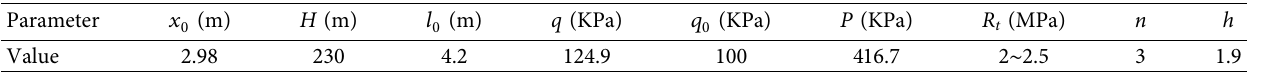
Table 4: Calculation of the values of each parameter of the hanging arch